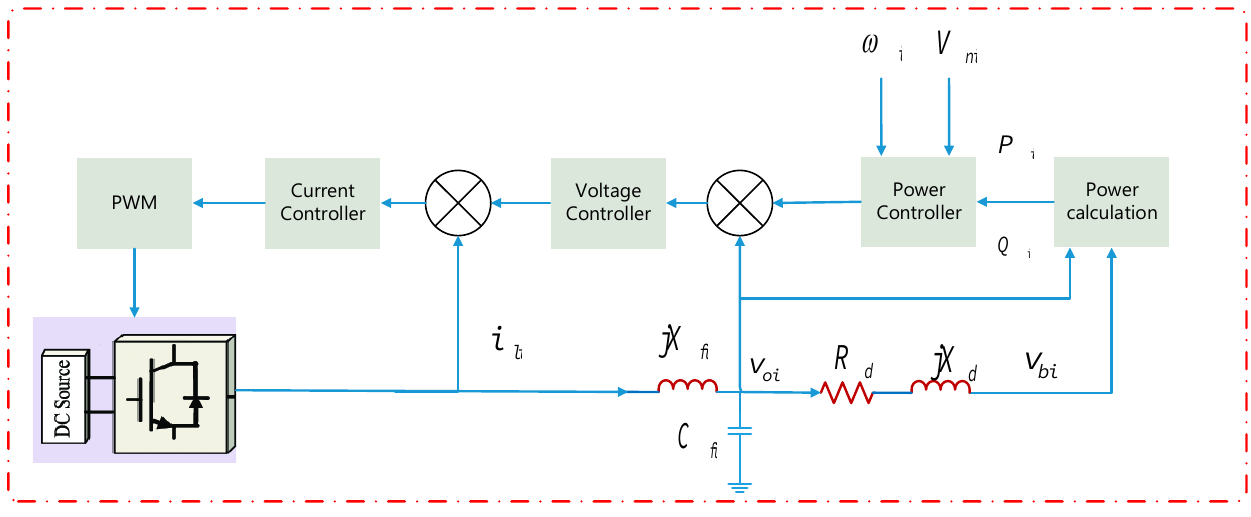
Figure 5. Schematic of control.